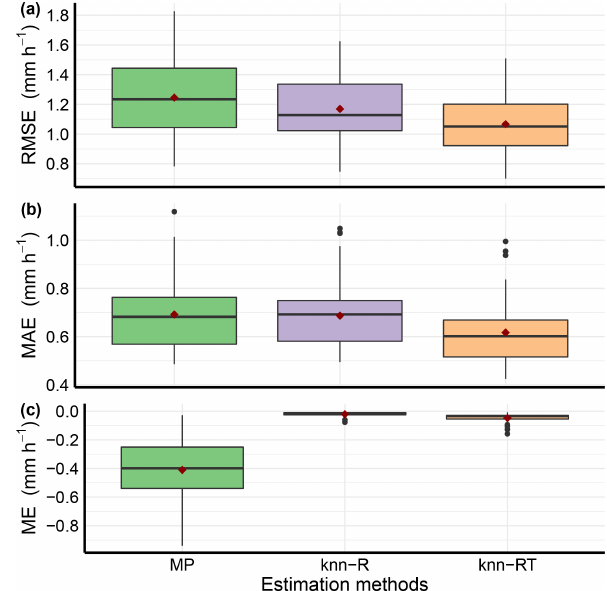
Figure 3. The percentage of improvement in RMSE at each gauge location (colour scale) for the predictive model with radar precipi- tation rate and air temperature as two predictors, with the single av- erage partial weight ( β R = 0 . 68 and β T = 0 . 32), compared to radar precipitation rate as a single predictor, overlaid on the coastline of the study area.